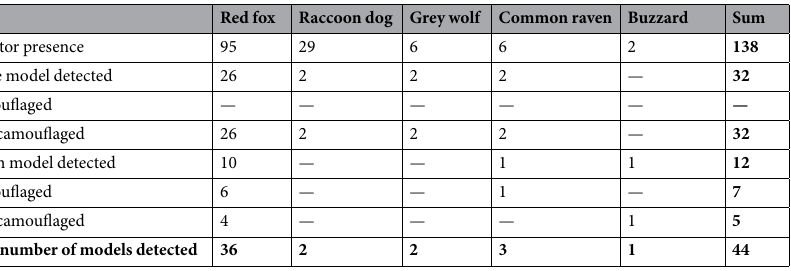
Table 1. Numbers of each predator (red fox Vulpes vulpes , raccoon dog Nyctereutes procyonoides , grey wolf Canis lupus , common raven Corvus corax , buzzard Buteo buteo and Buteo lagopus ) recorded by camera-traps at experimental sites and numbers of detected models (camouflaged and